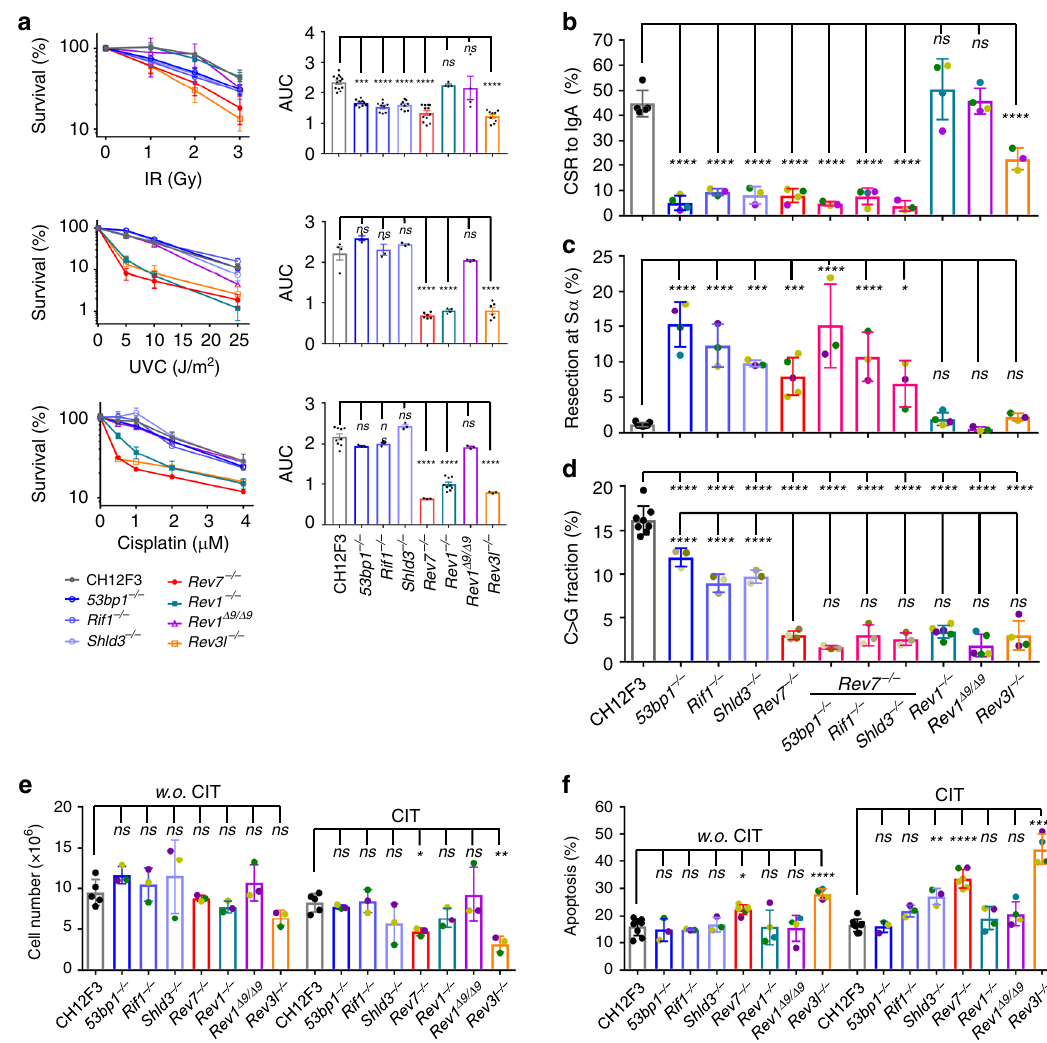
Fig. 2 REV7 and REV3L protect activated CH12 cells from cell death. a Survival curves of indicated CH12F3 cell lines upon γ -irradiation (IR), UVC, and cisplatin treatment are plotted as means± SD at left. Area-under-curve (AUC) are calculated and means ± SEM are compared at the right. In IR treatment, n = 13 for parental CH12F3 cells; n = 12 for Rev7 − / − ; n = 4 for Rev1 − / − and Rev1 Δ 9/ Δ 9 ; n = 9 for the other genotypes. In UVC treatment, n = 4 for parental CH12F3 cells and Rev1 − / − ; n = 6 for Rev7 − / − and Rev3l − / − . n = 3 for the other genotypes. In cisplatin treatment, n = 9 for parental CH12F3 cells; n = 9 for Rev1 − / − ; n = 3 for the other genotypes. CSR rate from IgM to IgA ( b ), end resection level in S α region ( c ), and percentage of C > G transversion in 5 ′ S μ region ( d ) are shown for the indicated cells. Cell numbers ( e ) and percentage of apoptotic population ( f ) with/without cytokine stimulation (CIT, w.o.CIT) at Day 3 are showed. Colored points indicate individual knockout clones. In b , n = 5 for parental CH12F3 cells; n = 4 for Rev7 − / − , 53bp1 − / − , Rev7 − / − Rif1 − / − , Rev1 − / − , and Rev1 Δ 9/ Δ 9 ; n = 3 for the other genotypes. In c , n = 7 for parental CH12F3 cells; n = 5 for Rev7 − / − ; n = 4 for 53bp1 − / − and Rev1 − / − ; n = 3 for the other genotypes. In d , n = 8 for parental CH12F3 cells; n = 4 for Rev7 − / − and Rev3l − / − ; n = 6 for Rev1 − / − ; n = 5 for Rev1 Δ 9/ Δ 9 , n = 3 for the other genotypes. In e , n = 5 for parental CH12F3 cells; n = 3 for the other genotypes. In f , n = 8 for parental CH12F3 cells; n = 6 for Rev7 − / − ; n = 4 for Rev1 − / − , Rev1 Δ 9/ Δ 9 , and Rev3l − / − ; n = 3 for 53bp1 − / − , Rif1 − / − , and Shld3 − / − . Three or more independent clones for each genotype were assayed and n represents independent experiments. Data are represented as mean ± SD; one-way ANOVA followed by Dunnett ’ s multiple comparisons test was performed for all panels. Data in knockouts are compared with those in parental CH12F3 cells for all panels. In d , an extra comparison is shown by using Rev7 − / − as the reference group to highlight the difference between DSBR de fi ciencies and TLS de fi ciencies. **** p < 0.0001, *** p < 0.001, ** p < 0.01, * p < 0.05, ns: p > 0.05. Source data are provided as a Source Data fi AID-initiated lesions lead to dysfunctional GC in REV7 de fi - Day 3 and 4 after stimulation (Fig. 4d). However, the G2/M arrest ciency . SHM of Ig V exons is required for antibody af fi nity in REV7 de fi ciency could not be rescued by Aicda deletion (Fig. 4e and Supplementary Fig. 10c). The G2/M fractions of maturation and also initiated by AID in GC B cells 12 . Cell death CSR-activated REV7 single-de fi cient and REV7/AID double- caused by AID-initiated DNA lesions in REV7 or REV3L de fi - de fi cient B cells were at a comparable level (Figs. 1f and 4e), ciency during CSR indicated similar mechanism could happen suggesting the G2/M phase arrest is not a major contributor of in vivo in SHM. The GC B-cell numbers in the spleen or Peyer ’ s the higher apoptosis rate in REV7-de fi cient cells. We conclude patch of SRBC (sheep red blood cell)-immunized REV7-de fi cient that AID-initiated DNA lesions are the cause of cell death in mice were signi fi cantly decreased (Fig. 5a, b). The size of GC REV7 de fi ciency. decreased in REV7-de fi cient spleens (Fig. 5c) and the fl oxed allele